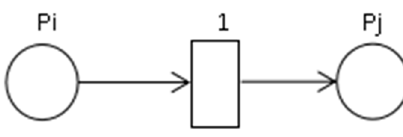
Figure 4. Full variation rule ( X i > γ T H i ).